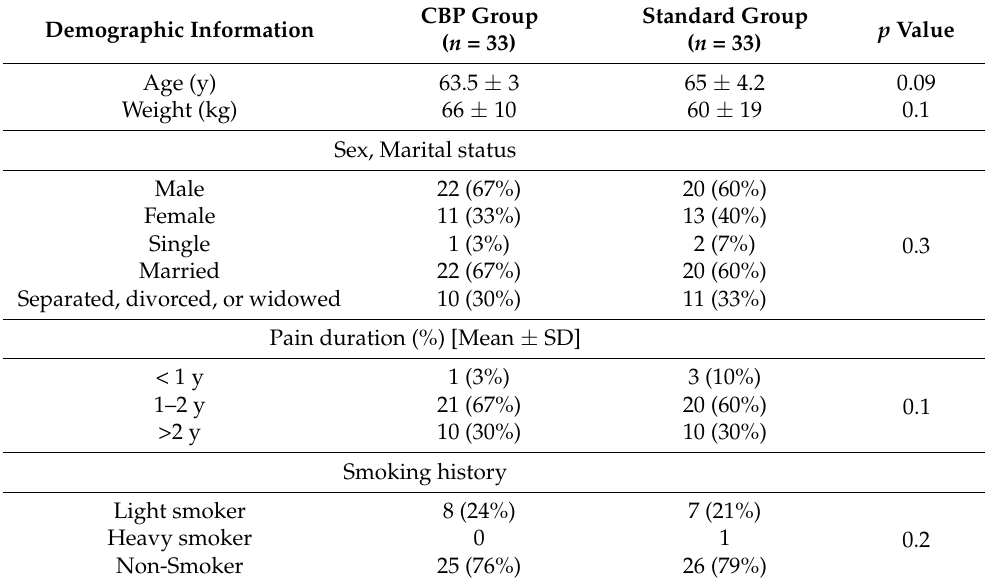
Table 1. Baseline participant demographics. CBP is the group receiving mirror image exercise plus the Denneroll™ cervical traction orthotic (DCTO). The standard group is the group receiving standardized strengthening and stretching exercises to correct FHP. Values are expressed as means ± standard deviation (SD) where indicated. Demographic Information